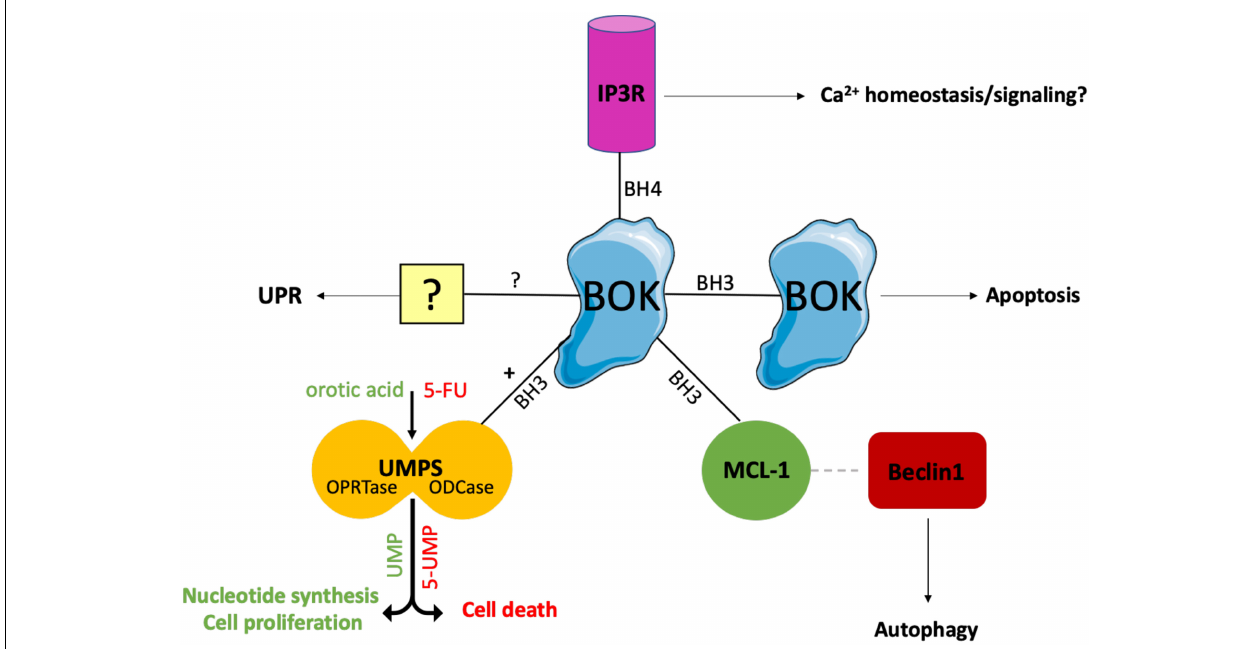
FIGURE 1 | Interaction partners of BOK. Only few BOK interacting partners have been described so far. Using yeast two-hybrid screens, BOK was found to interact with MCL-1. This interaction has been proposed to promote autophagy, as BOK binding to MCL-1 frees MCL-1–bound Beclin-1, which in turn initiates the autophagy machinery. Moreover, BOK is constitutively bound to IP3Rs (IP3R1 and IP3R2) at the ER via its BH4 domain. IP3Rs may act as a regulatory sink for BOK to keep the levels of unbound (“free”) BOK low. Furthermore, co-immunoprecipitation experiments indicated that BOK may interact with itself in a BH3 domain–dependent manner. Whether BOK truly forms dimers or homo-oligomers and whether this oligomerization induces MOMP need to be further investigated. Recently, BOK was found to interact with and increase the activity of the enzyme UMPS via its BH3 domain. UMPS catalyzes the last two steps of the de novo synthesis of UMP and is central for metabolizing the chemotherapeutic drug 5-FU into its active metabolites. As a result, cells lacking BOK have a defect in uridine metabolism, leading to decreased cellular proliferation compared to WT controls. On the other hand, Bok - / - cells are resistant toward 5-FU treatment. Losing BOK seems to confer a selective advantage to CRC cells, and consequently, BOK expression levels are suggested to be useful as a prognostic marker in CRC and as a predictive marker for the efficacy of 5-FU treatment in CRC. While there is increasing evidence for a UPR-modulating role for BOK, the exact mechanism and possible interaction partners for UPR modulation and the ER stress response are still